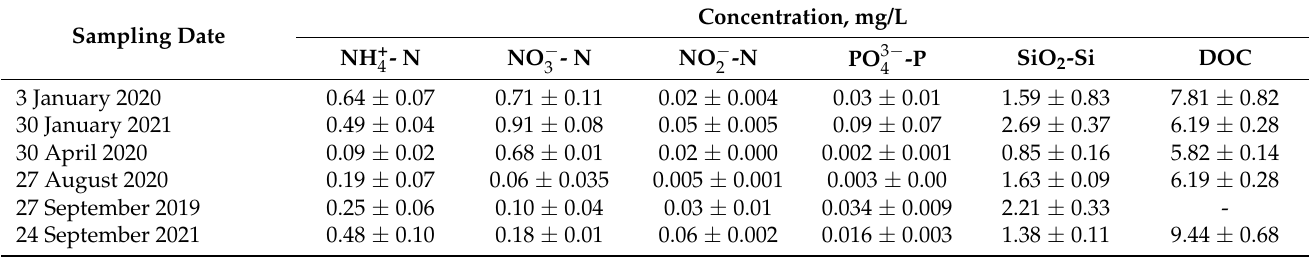
Table 3. Averaged concentrations of nutrients and DOC in surface water from three stations at Lake